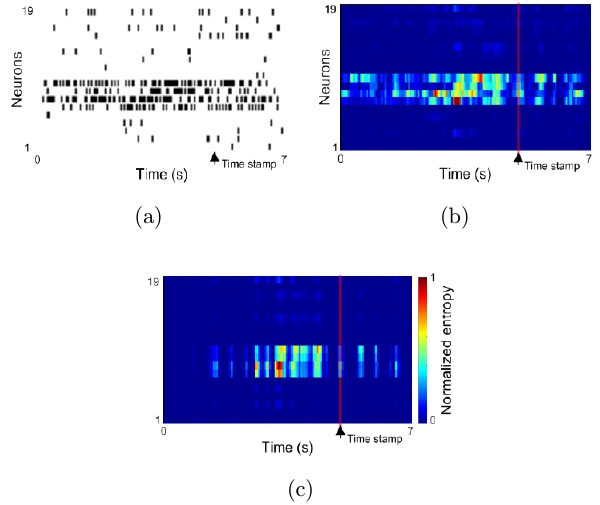
Fig. 9. Neuronal ensemble sparse coding when using di®erent (cid:1) . (a) Spike trains. (b) Neuronal ensemble sparse coding. (cid:1) ¼ 0 : 2. (c) Neuronal ensemble sparse coding. (cid:1) ¼ 0 :